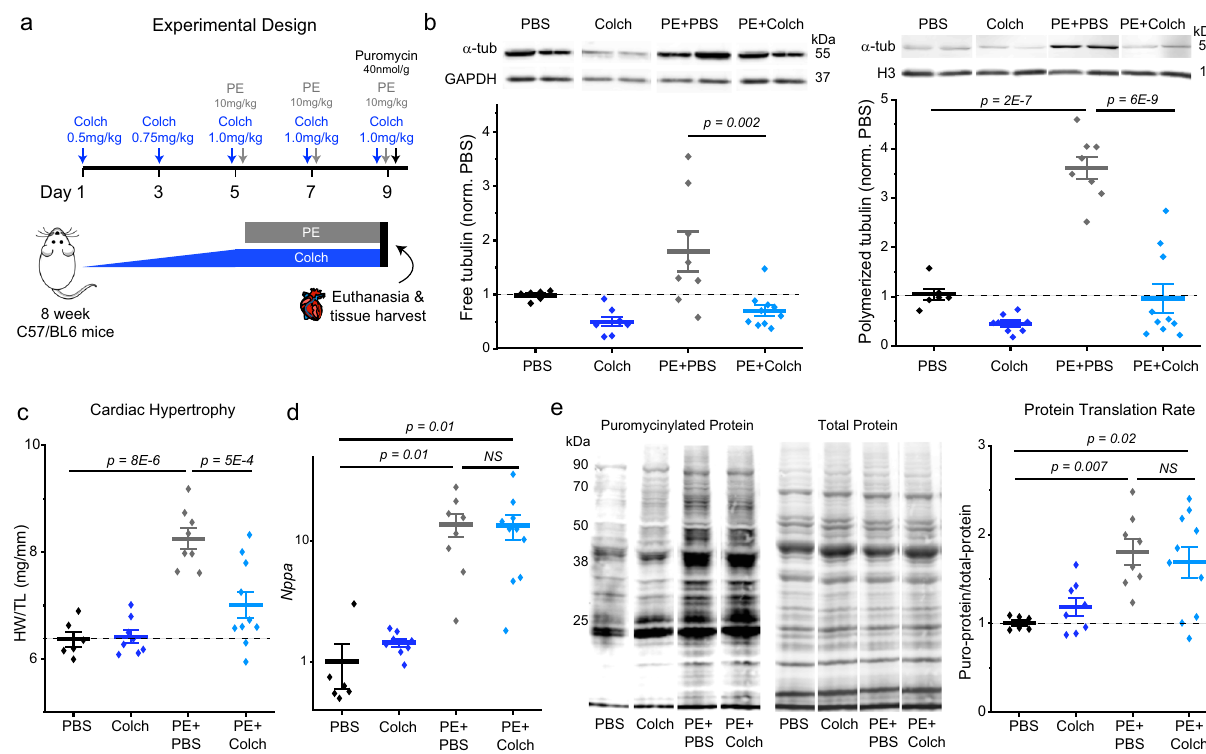
Fig. 1 Microtubule depolymerization uncouples increased protein translation from cardiac growth. a Experimental design for PE-induced hypertrophy mouse model. b Representative western blot images of free α -tubulin and loading control GAPDH (top left) and quanti fi cation of normalized free tubulin from each group (bottom left). Representative western blot images of polymerized α -tubulin and loading control Histone H3 (top right) and quanti fi cation of normalized polymerized tubulin from each group (bottom right). c Quanti fi cation of cardiac hypertrophy. d Quanti fi cation of Nppa expression. e Representative western blots for puromycinylated proteins (left) and total protein (center). Quanti fi cation of translation rate (right). For all panels, statistical signi fi cance determined via one-way ANOVA with post hoc Bonferroni comparisons. For all panels, PBS ( N = 6), Colch ( N = 8), PE + PBS ( N = 8), and PE + Colch ( N = 10). For all graphs shown in fi gure, the mean line is shown, with whiskers denoting standard error (SE) from the mean. Source data are provided as a Source data fi